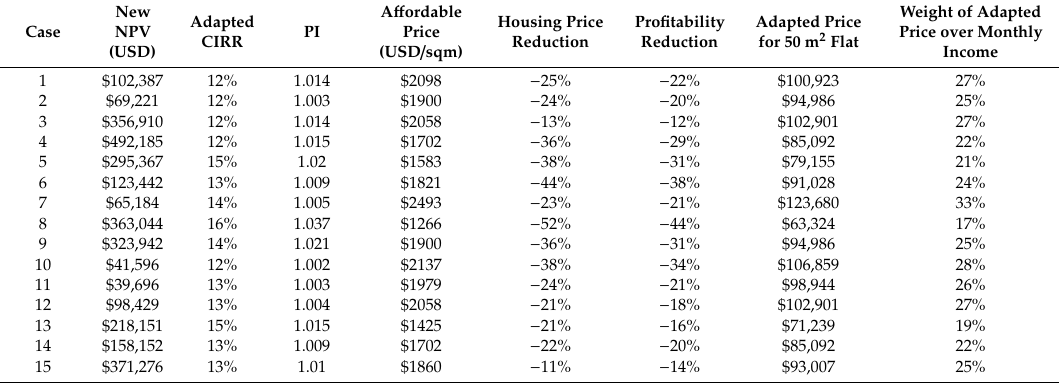
Table 5. Evaluation of the house price by adjusting the USD / sqm value of the projects to be marketed, maintaining a CIRR between 10% and 16% as a range, safeguarding that PI is above 1 and ensuring that the NPV exceeds USD 30,000. Source: Prepared by